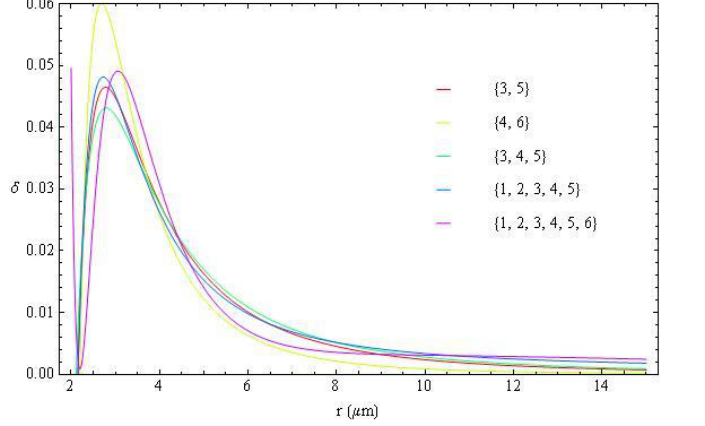
Figure 20. Radial dependence of the birefringence parameter ( ) r  , Equation (18), obtained from the fittings shown in Figure